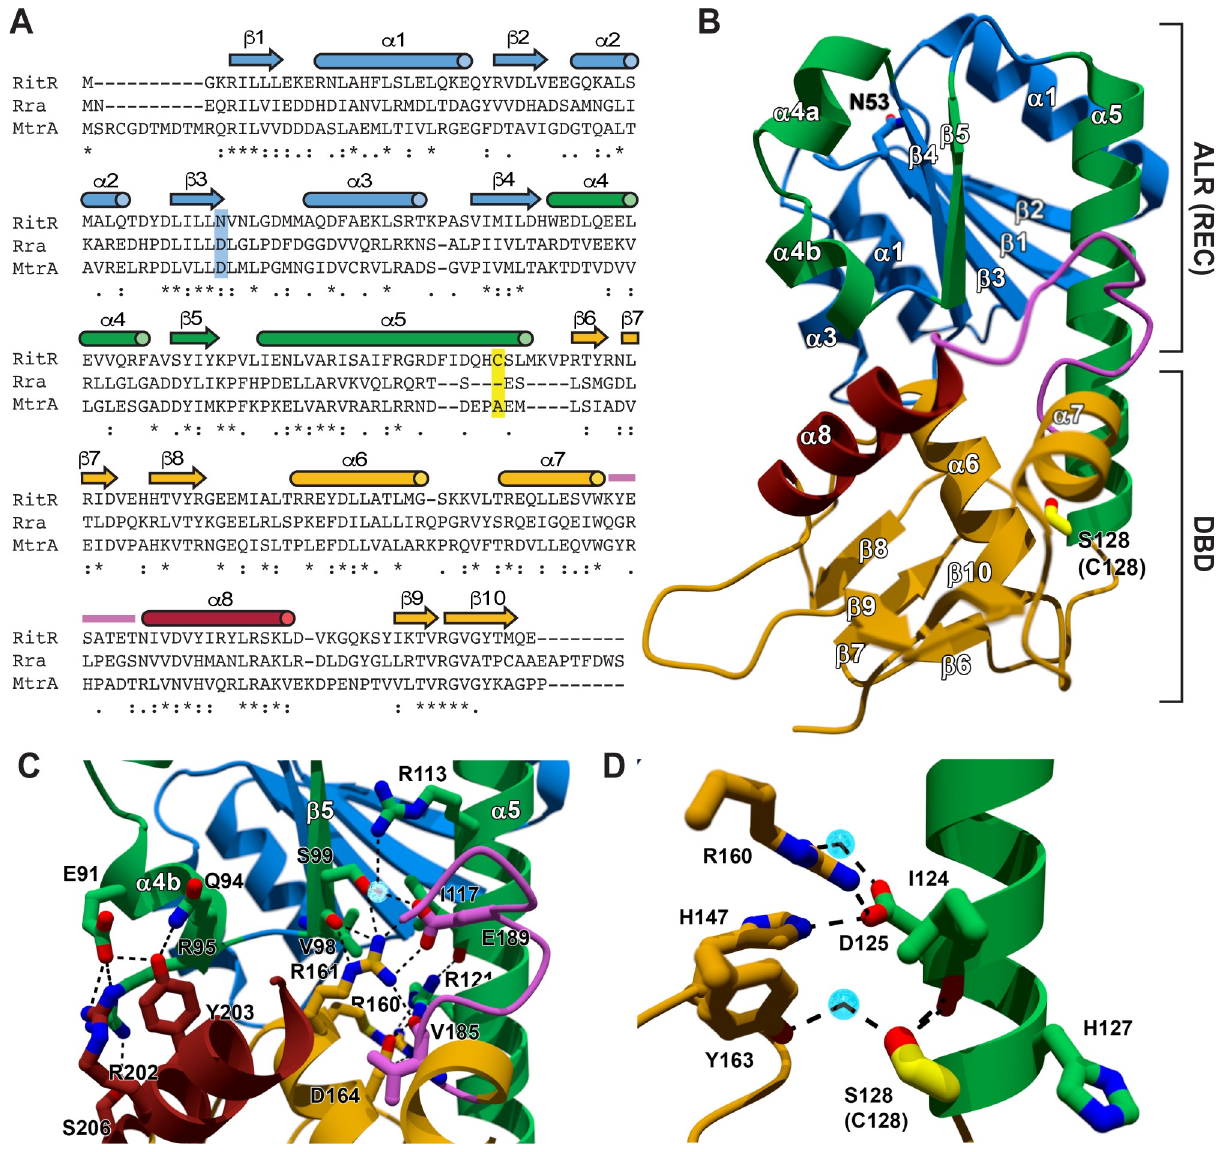
Fig 3. Structure of the ‘reduced’ RitR C128S. ( A ) RitR Clustal Omega annotated alignment of RitR and two other full-length response regulators with available structures (MtrA from Mycobacterium tuberculosis , PDB ID 2GWR, and Rra from Deinococcus radiodurans , PDB ID 3Q9S). Identity is denoted by an asterisk and similarity by dots/colons. Secondary structure depicted above the sequences is color coordinated with the 3D models presented in B-D .The reactive Cys128 position is shaded in yellow, and the position which normally contains the phosphorylated Asp residue shaded in blue (note in RitR it is an Asn instead). ( B ) Ribbon diagram of the full-length, monomeric (’reduced’ / inactive) RitR C128S . Ser128 (Cys128 coordinate) is labeled, colored yellow and appears in ball-and-stick format. The α 4- β 5- α 5face of the REC domain used by canonical response regulators for dimerization is shown in green. The remainder of the REC domain is blue. The DNA-binding domain is gold, save for the recognition helix (red) and the trans- activation loop (magenta) that interacts with RNA polymerase to direct transcription [48, 49]. ALR, Aspartate-less receiver domain [30]; DBD, DNA- binding domain. ( C ) Close-up of the RitR DBD-REC interface shown with the same coloring. The residues comprising the interface are shown as ball- and-stick. ( D ) Close-up of the Ser128 (Cys128 coordinate) interactions with neighboring residues and water molecules. Dotted lines denote predicted electrostatic interactions. Oxygen atoms are shown in red, nitrogens in blue and water molecules as light blue circles. Images were created using MOLSCRIPT and POVRay